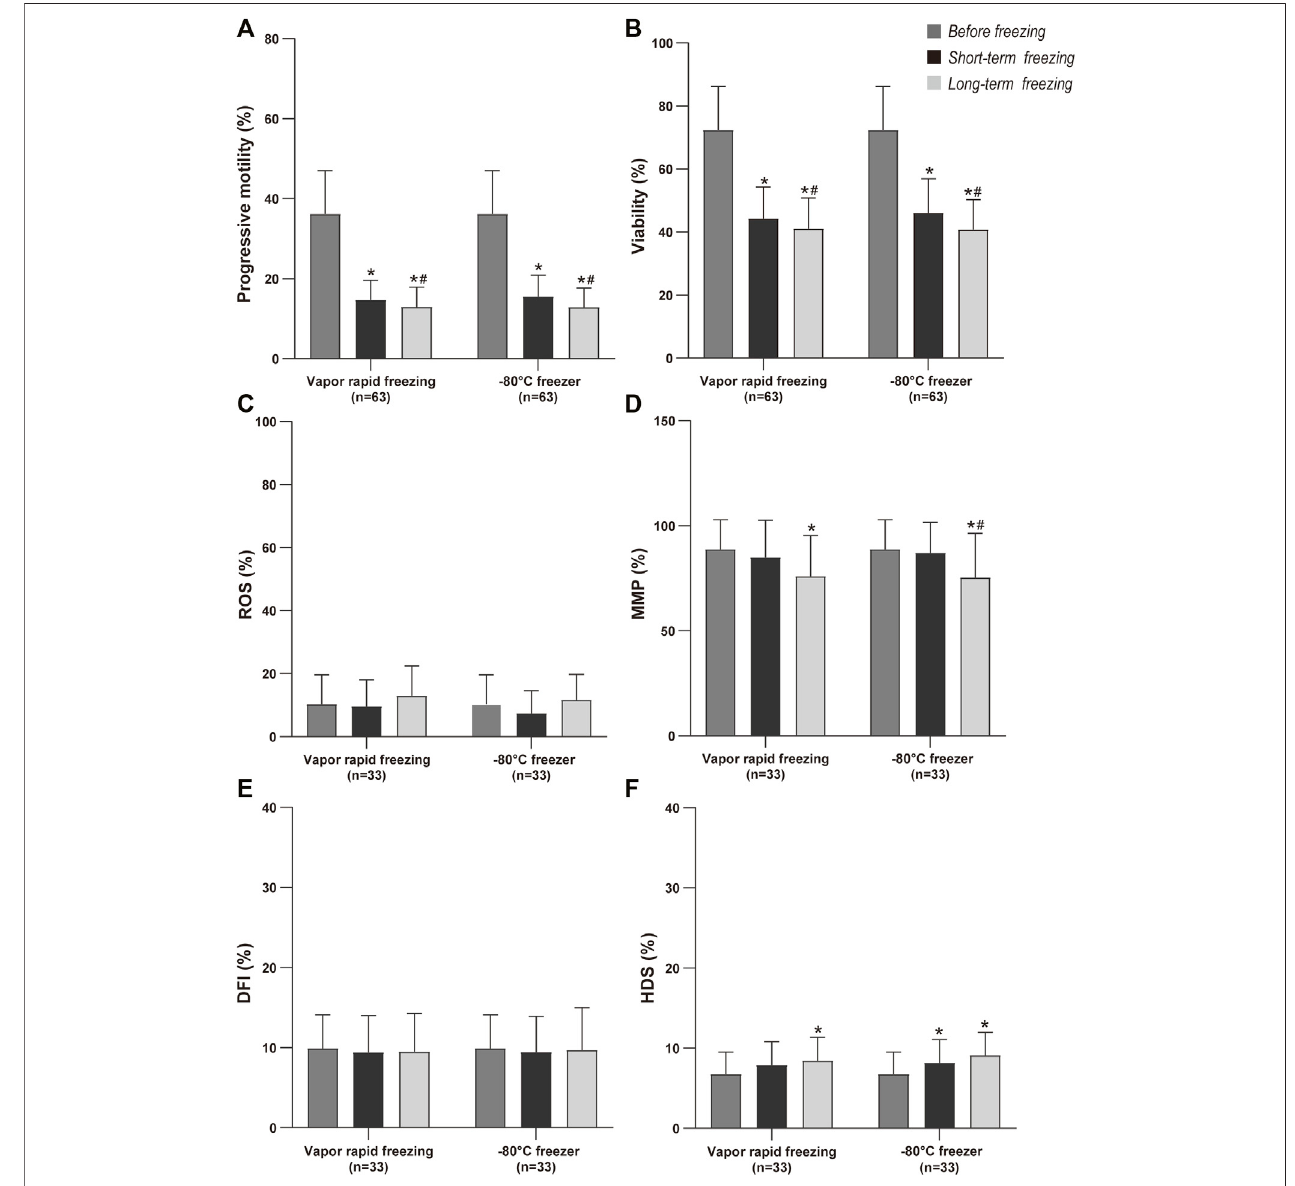
FIGURE 3| Comparison of sperm quality bycryopreservation time before freezing, short term and long-term freezing. Values are mean and bar are SD; *p-value < 0.05 compare with before freezing (paired t-test); # p-value < 0.05 compare with short-term freezing (paired t-test).